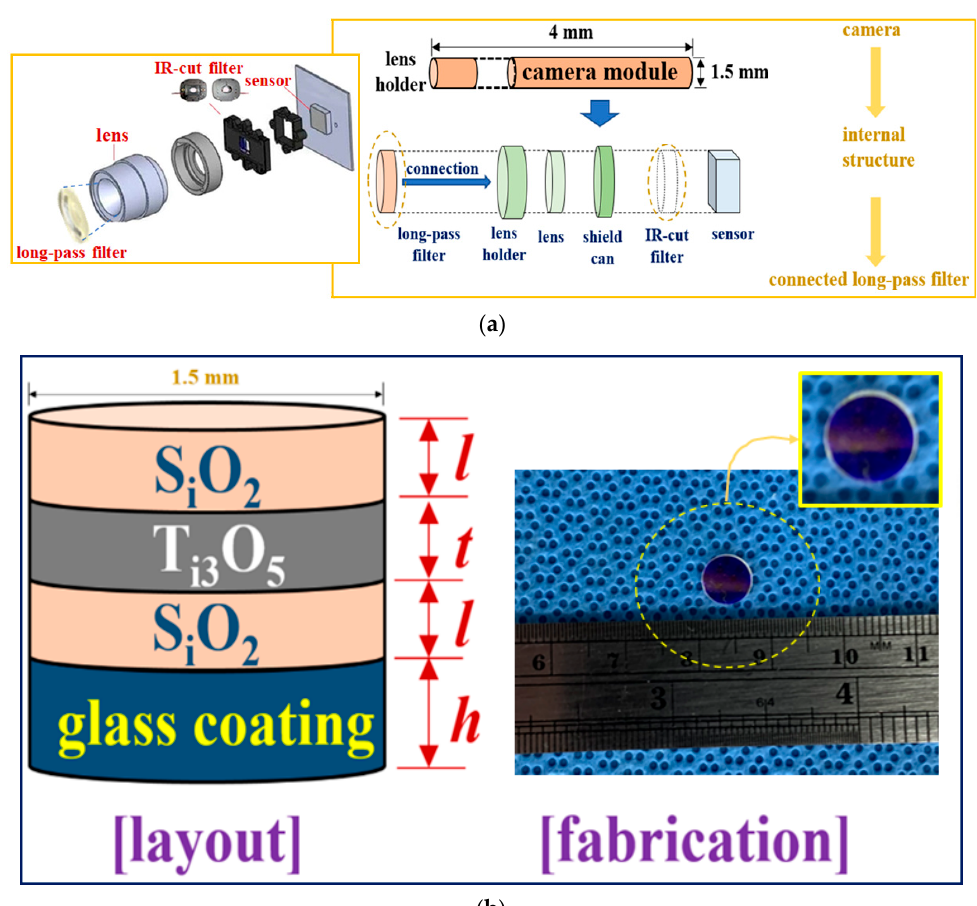
Figure 3. Camera module and long-pass filter ( a ) structure of the connection between the camera module and the long-pass filter ( b ) fabrication of long-pass filter.